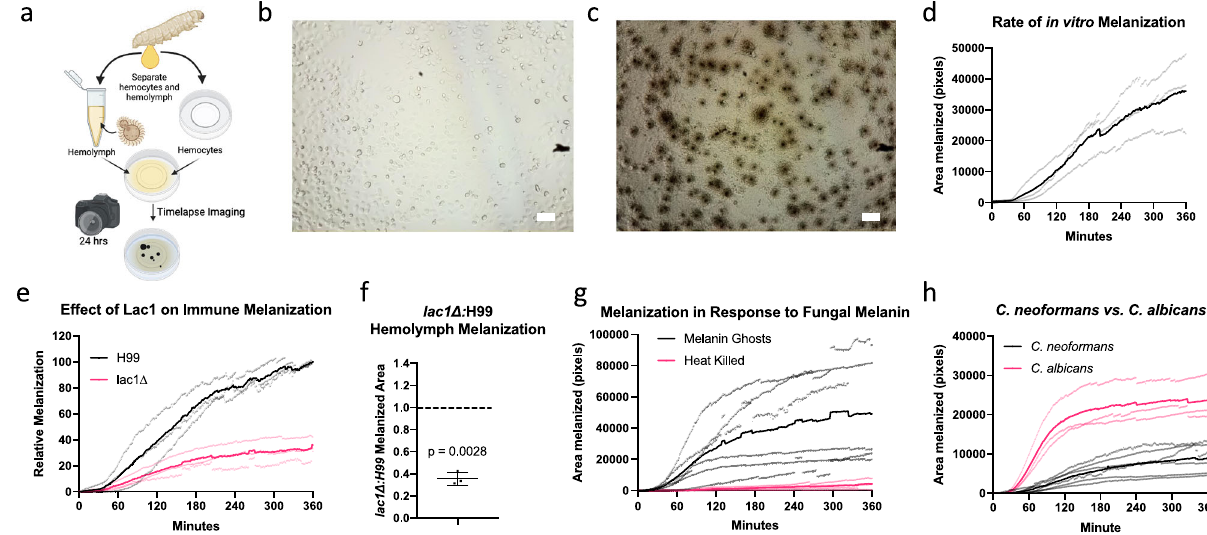
Fig. 2 Using in vitro time-lapse microscopy to visualize the melanin-based immune response. a Using a developed time-lapse microscopy protocol, we were able to record the dynamics of hemolymph melanization in response to C. neoformans from 0 ( b ) up to 24 h ( c ). We can then use particle measurement software to visualize and quantify the melanization reactions over time ( d ), representative of three biological replicates. This method can be used to gain insight into how different virulence factors, such as laccase, in fl uence the melanization response, where we see that the laccase knockout mutant causes less of a melanization response without much change in time until onset of melanization ( e ), represented by three biological replicates, and normalized to the wild-type control melanization area at 360 min. f Overall, the lac1 Δ triggers ~40% as much of a melanization immune response compared to the WT (one sample t -test, n = 3 biologically independent movies, p = 0.0028, t = 18.78, df = 2). g Isolated fungal melanins are associated with activation of the insect-melanin-based immune response, whereas the heat-killed acapsular cryptococcal cells are not, as represented by 3 – 6 biological replicates. h Additionally, we can compare the activation of the melanin-based immune response from different fungal species such as C. neoformans and C. albicans, which strongly activates the melanization immune response, represented by 3 – 6 biological replicates. b – d , g are representative images and graphs from three biological replicates. Error bars indicate Standard Deviation. d , e , g , h Solid lines indicate mean melanization, and light colored points indicate individual replicate data points. Scale bars represent 50 µ